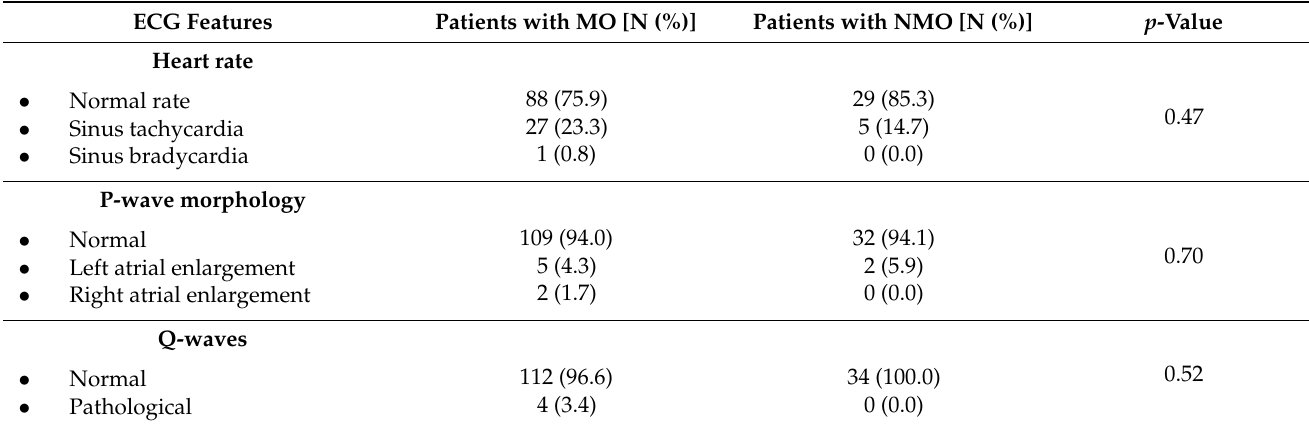
Table 3. Summary of ECG features: comparison of patients with morbid obesity (MO) and non- morbid obesity